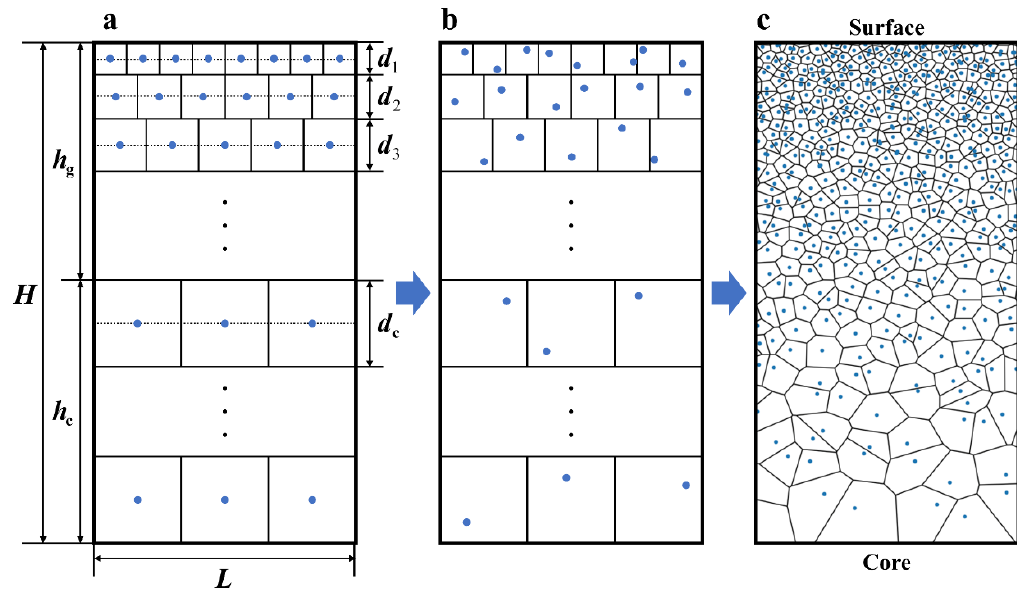
Figure 3. The generation process of the grain size gradient microstructure of the gradient Cu using the Voronoi tessellation: ( a ) initial seed positions, ( b ) perturbed seed positions, and ( c ) schematic of the generated gradient grains.